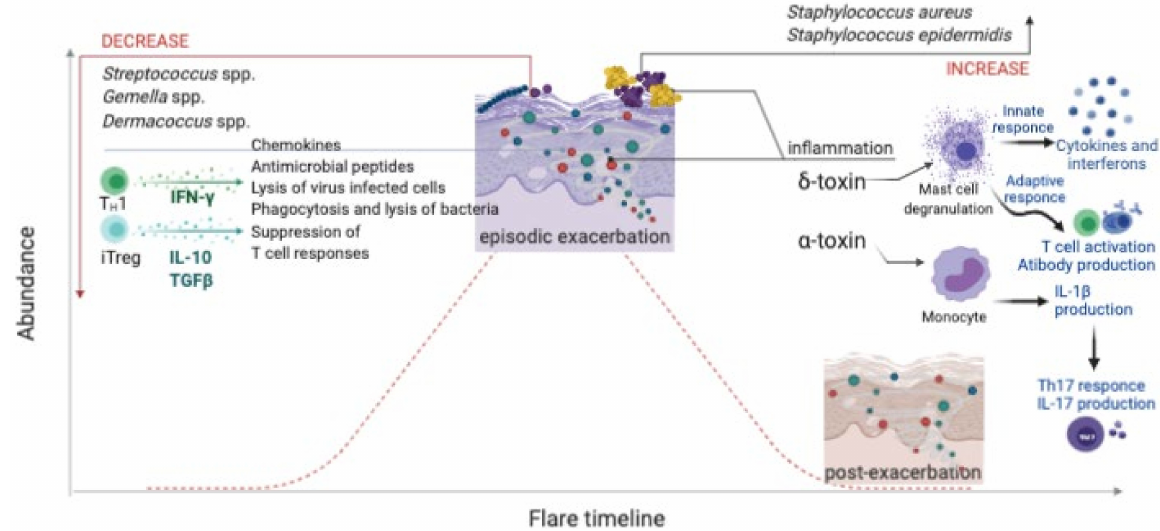
Figure 2. Dysbiosis in atopic dermatitis and its link to the skin immune response